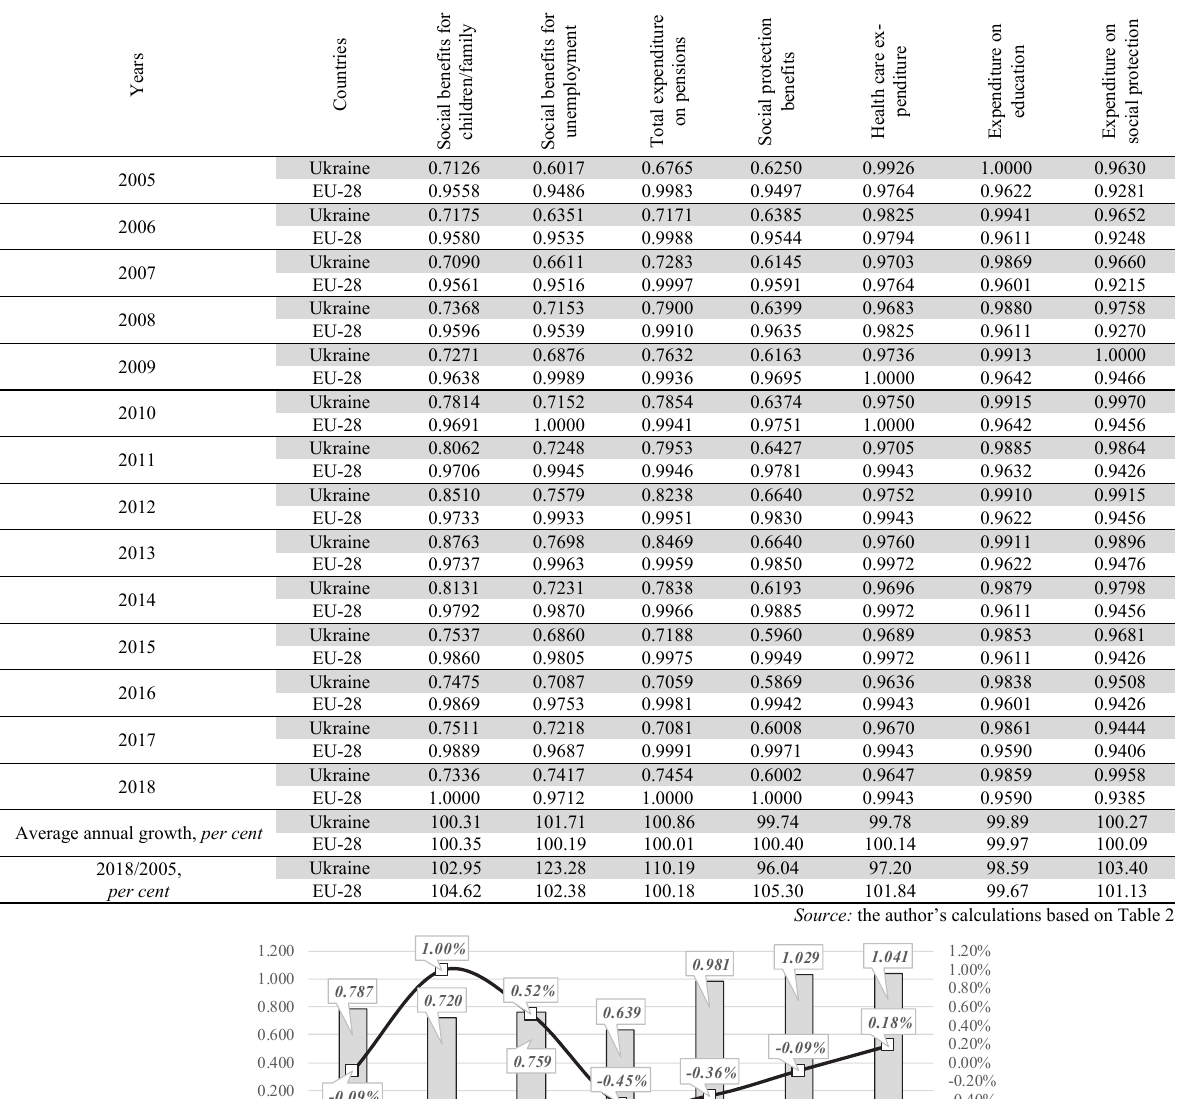
Indices of indicators of the social sphere development in Ukraine and the EU-28, 2005-2018